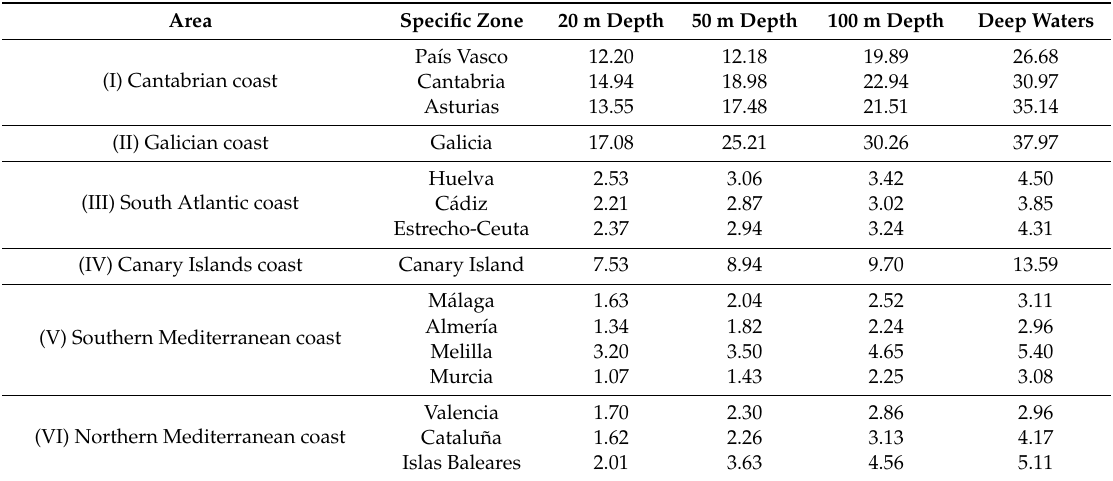
Table 2. Annual average wave power, in kW / m, in all the areas in the Spanish